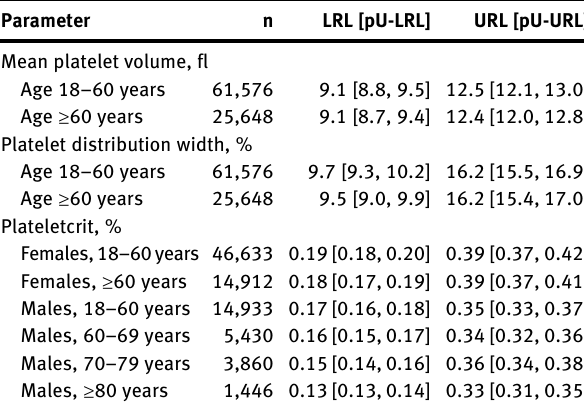
Table  : Indirect reference intervals for platelet indices in seniors. Parameter